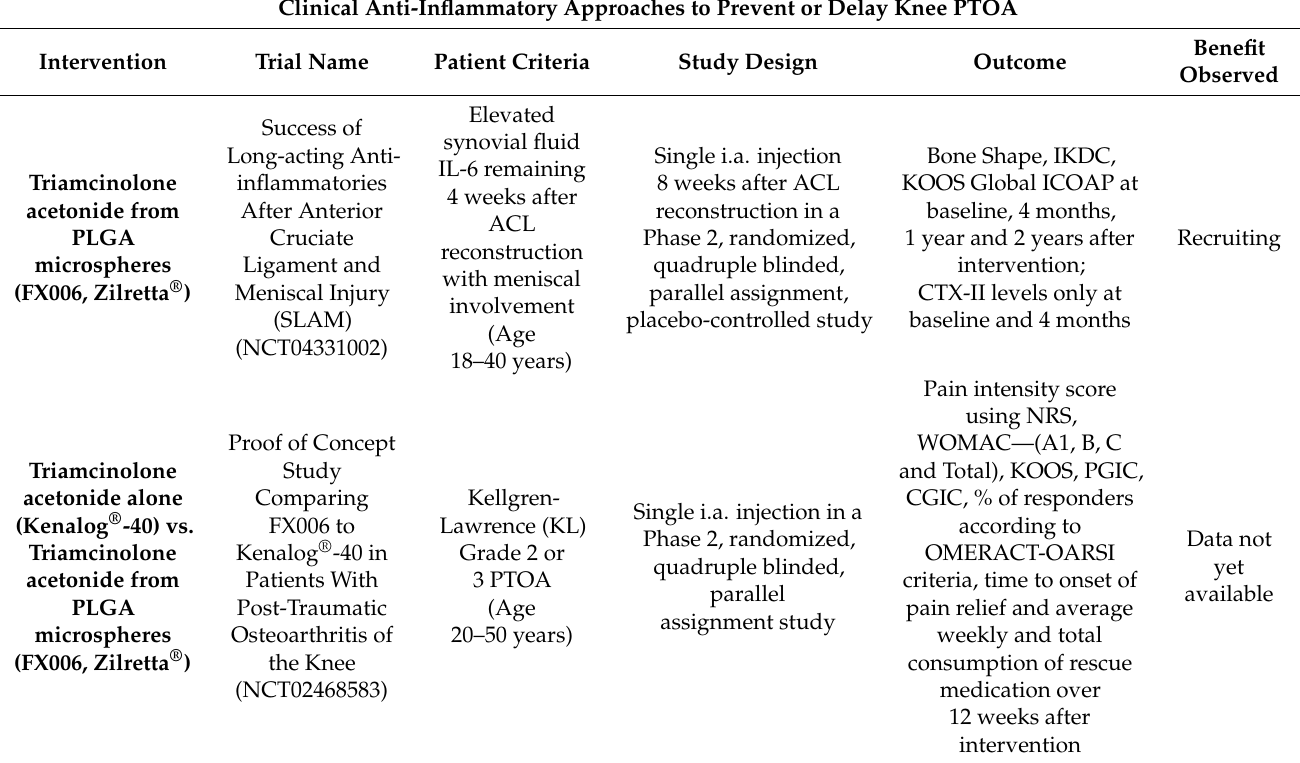
Table 1. The few clinical trials aimed at preventing or delaying knee PTOA. Clinical Anti-Inflammatory Approaches to Prevent or Delay Knee